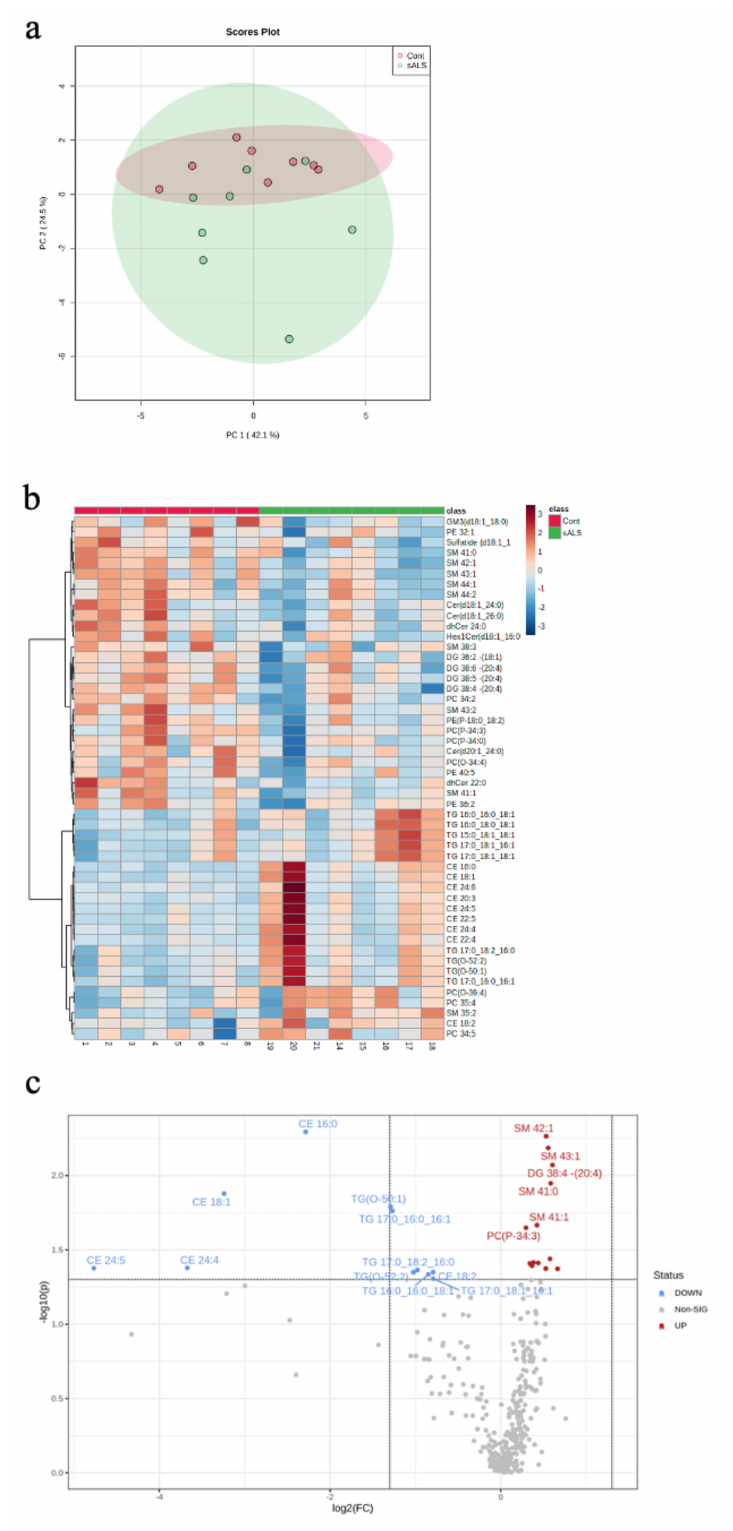
Figure 1. Targeted lipidomic analyses of motor cortex white matter in ALS versus control. ( a ) A PCA plot depicting separation of ALS samples (sALS; n = 8) from age- and sex-matched controls (n = 8); ( b ) a heatmap highlighting the 50 most differentially expressed lipid species grouped as control (pink) and sALS (green) (above heatmap) identified by case number (below heatmap; see Table 1); ( c ) a volcano plot highlighting the lipid species that are significantly increased (blue) and decreased (red) in sALS compared to